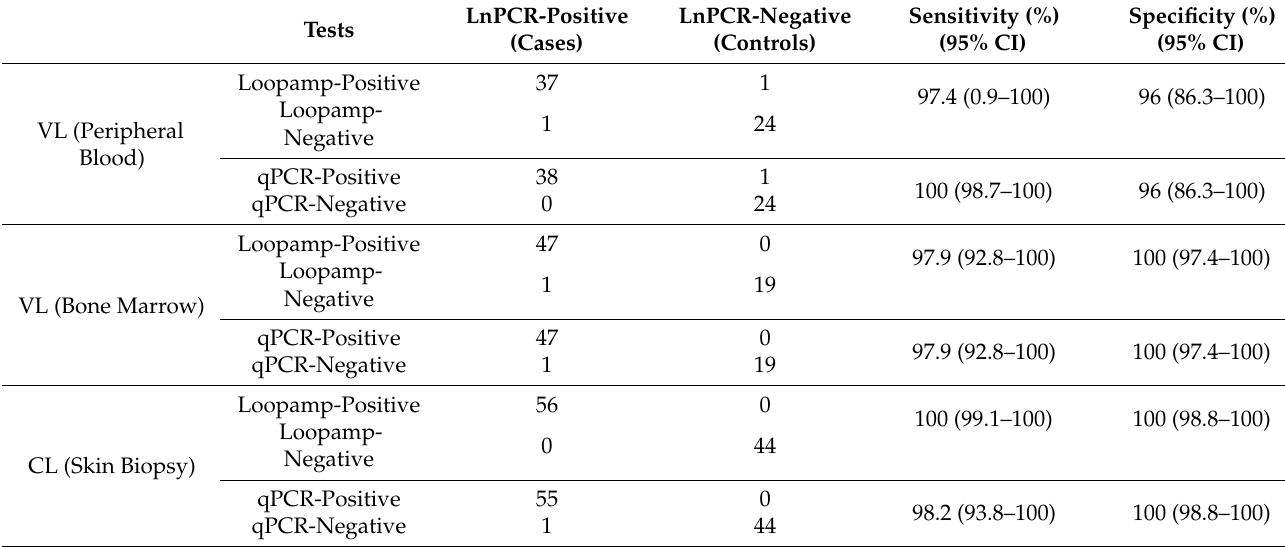
Table 2. Diagnostic Performance of Loopamp and qPCR on Samples from CL and VL Suspected Cases, Using LnPCR as Reference.